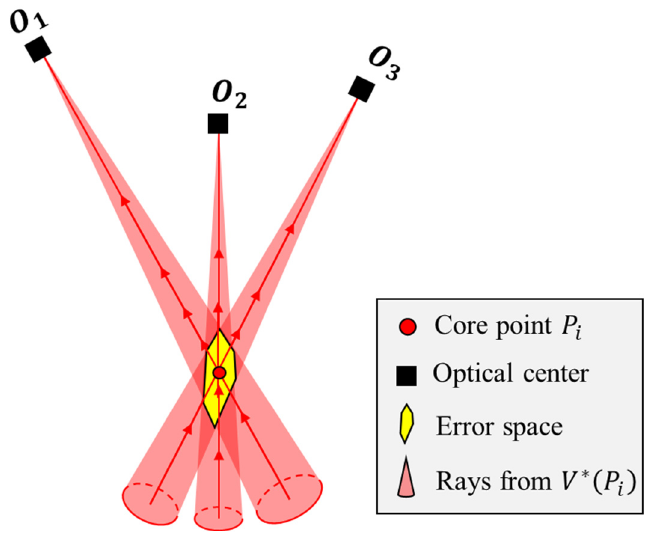
Figure 4. Boolean operation and error space.